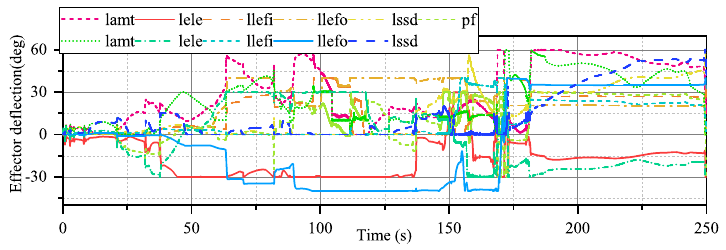
Figure 22. Effector deflections without